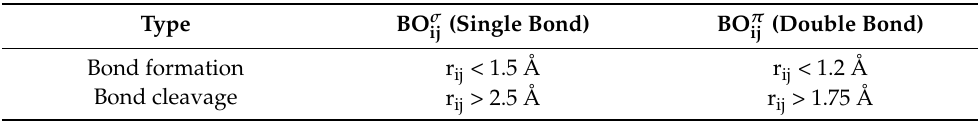
Table 1. Relationship between the atomic distance and bond formation and